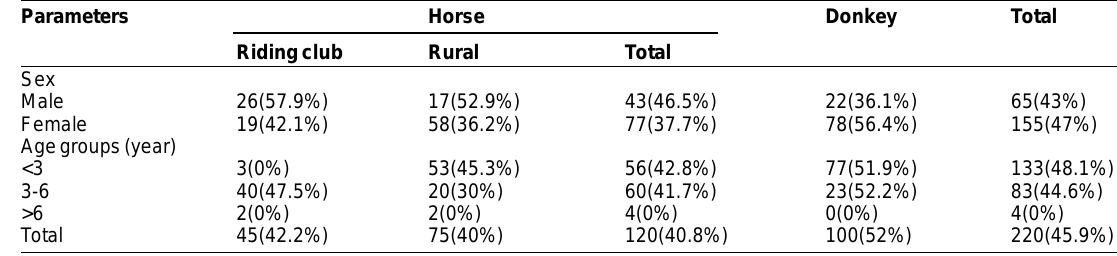
Table-1. Seroprevalence of Neospora sp. in different gender and age groups in horses and donkeys from western Iran. Parameters